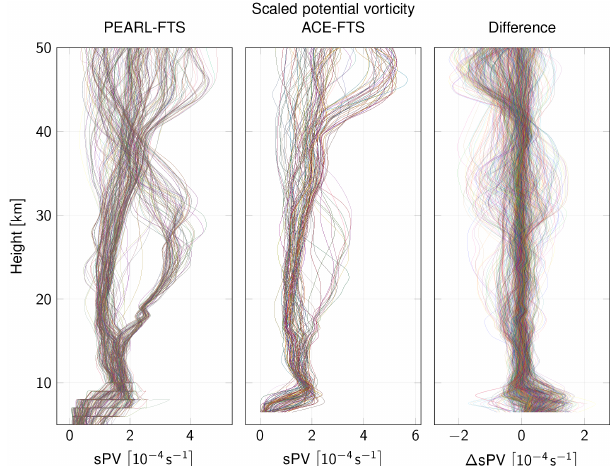
Figure 8. Profiles of sPV as a function of geometric height, for PEARL-FTS (left panel) and ACE-FTS (centre panel). The right panel shows difference profiles, i.e. sPV ACE-FTS − sPV PEARL-FTS . For the difference figure, ACE-FTS sPV profiles were interpolated onto the vertical grid of PEARL-FTS profiles. Only collocated pairs are